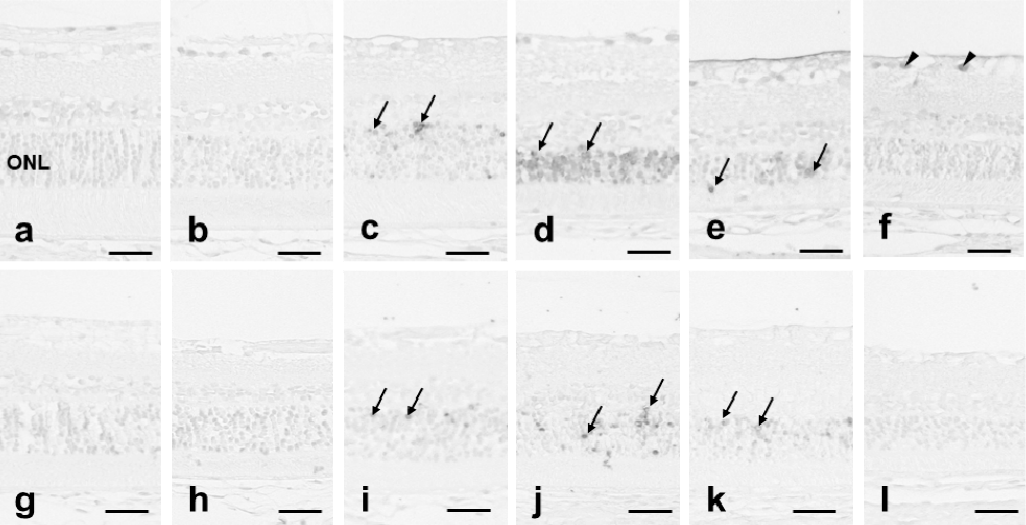
Figure 3. Terminal deoxynucleotidyl transferase (TdT)-mediated 2 (cid:48) -Deoxyuridine-5 (cid:48) -triphosphate dUTP nick end labeling. Superior retinal samples obtained 500 µ m from the optic nerve are seen. ( a – f ) In quercetin ( − ) retina, TUNEL-positive cells are seen in the ONL (arrows) and ganglion cell layer (arrowheads). ( g – l ) In quercetin ( + ) retina, although some TUNEL-positive cells are seen in the ONL (arrows), there are much fewer than in the quercetin ( − ) retina. ( a , g ) Unexposed retinas; ( b , h ) retinas exposed to light for 12 h; ( c , i ) retinas exposed to light for 24 h; ( d , j ) 1 day after light exposure; ( e , k ) 3 days after light exposure; and ( f , l ) 7 days after light exposure. Bar = 25 µ m. n = 6 in each group.